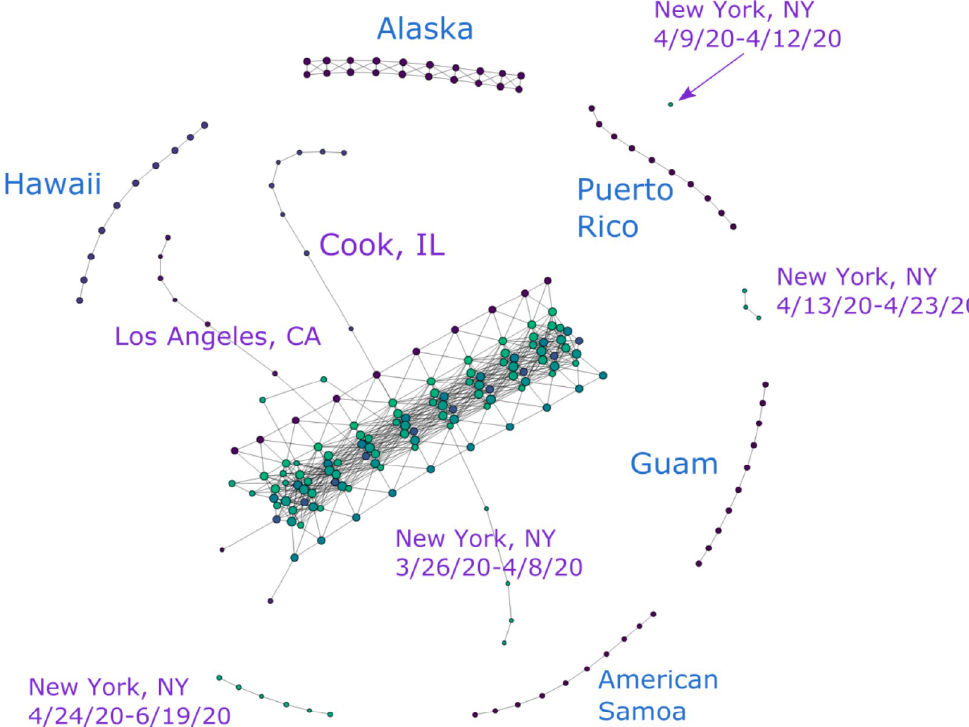
Fig 2. COVID-19 cases reported in the U.S. as of 6/19/20. ( n = 10, δ = 8%).